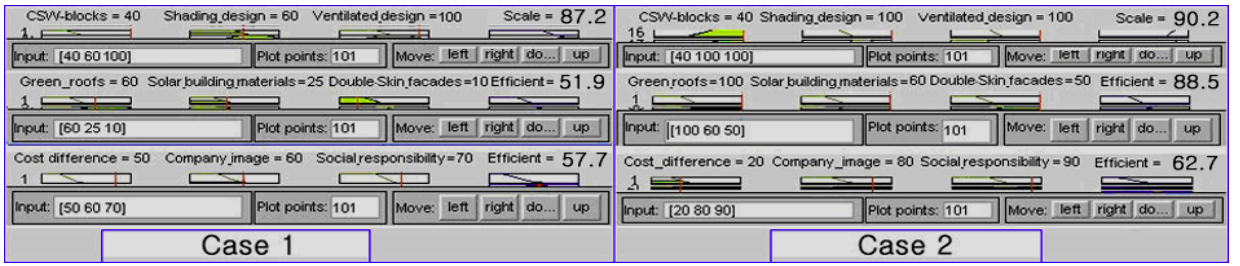
Figure 7. Quantified output values calculated by FLIS for Cases 1 and 2.